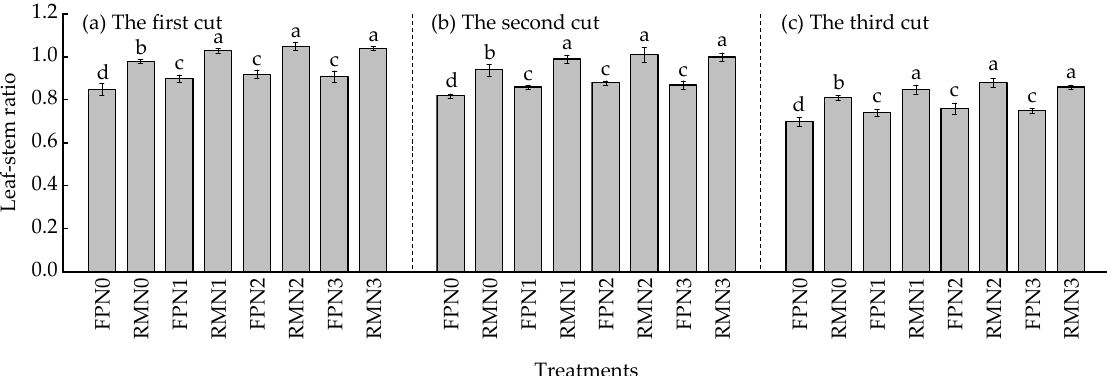
Figure 5. Impact of planting pattern and nitrogen level on the leaf:stem ratio of alfalfa. FP and RM refer to conventional flat planting and ridge culture with film mulching, respectively. N0, N1, N2, and N3 refer to nitrogen application rates of 0 kg · ha − 1 , 80 kg · ha − 1 , 160 kg · ha − 1 , and 240 kg · ha − 1 . Different lowercase letters indicate significant difference among treatments ( p < 0.05).